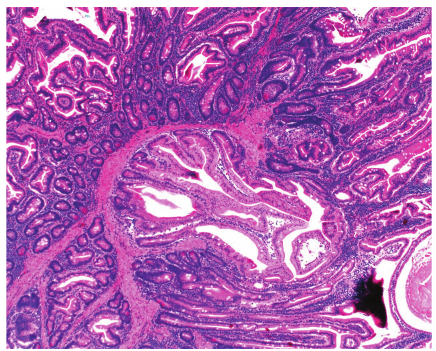
Figure 7: The benign adenomatous histology of one of the patient’s Peutz-Jeghers polyps.